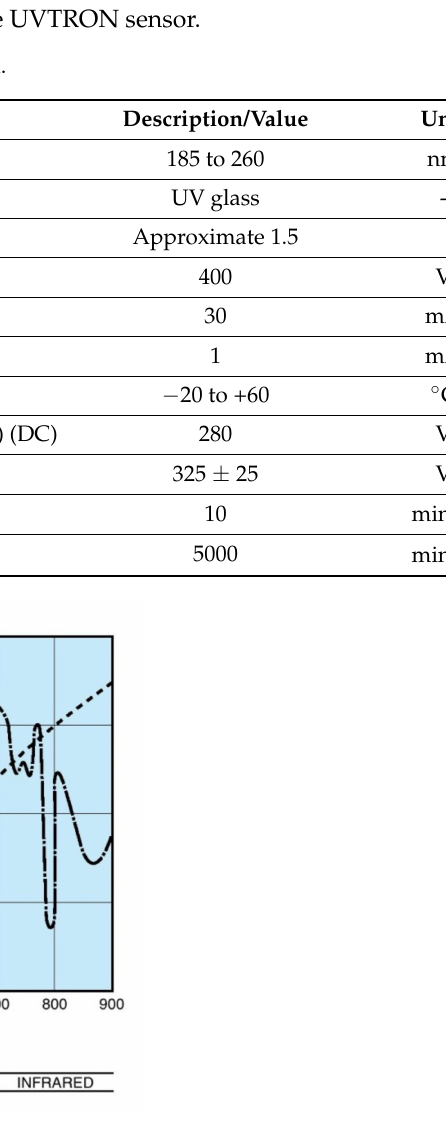
Figure 4. Comparison between discharge ultraviolet spectrum and visible light spectrum